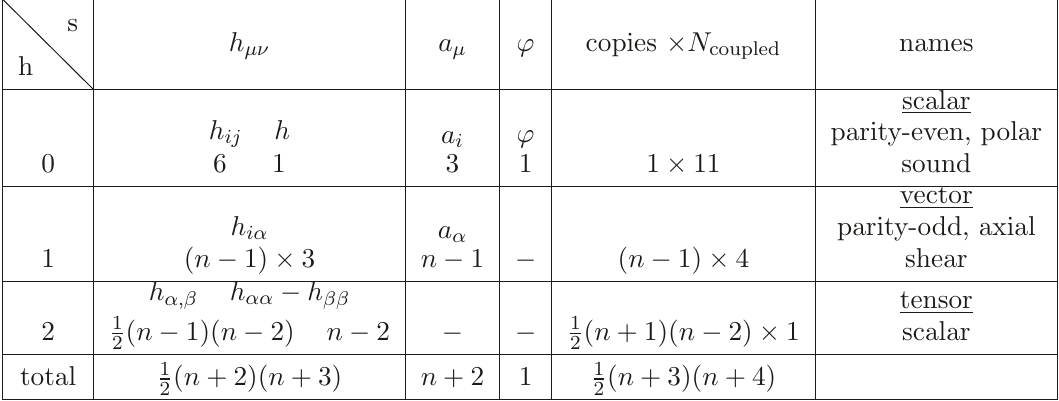
Table 1 . Decoupling of perturbations into sectors. Under each perturbation we note the number of components involved. In the rightmost column we list some names that are common in the literature for these sectors, here we use the underlined